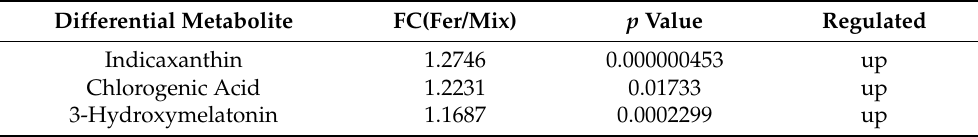
Figure 9. Analysis of differential metabolites. PLS − DA analysis ( A ) was performed to show the variation in metabolites diversity between the Fer and Mix groups. A volcano plot ( B ) was used to analyze the differential metabolites in the Fer and Mix groups. Gray dots denote non − significant differential metabolites, blue dots denote significantly downregulated metabolites ( p < 0.05), and red dots denote significantly upregulated metabolites ( p < 0.05). HMDB compound classification analysis ( C ) was used to classify and annotate differential metabolites. Table 4. The FC of key upregulated differential metabolites between the Fer and Mix groups. Differential